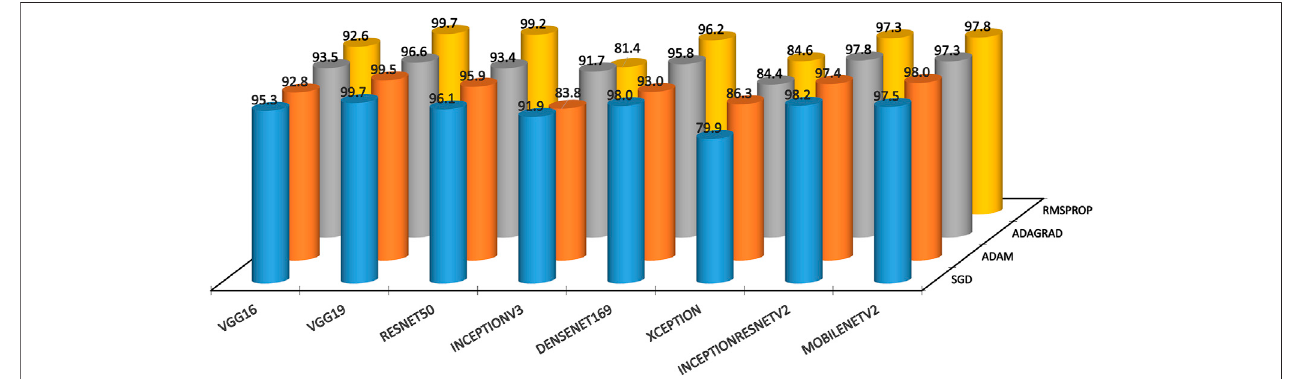
TABLE 7 | Performance evaluation based on precision, recall, and F1 scores for two-class classi fi cation [Accuracy (%)]. Sr. No. Model – optimizer Precision Recall F1 Score Accuracy